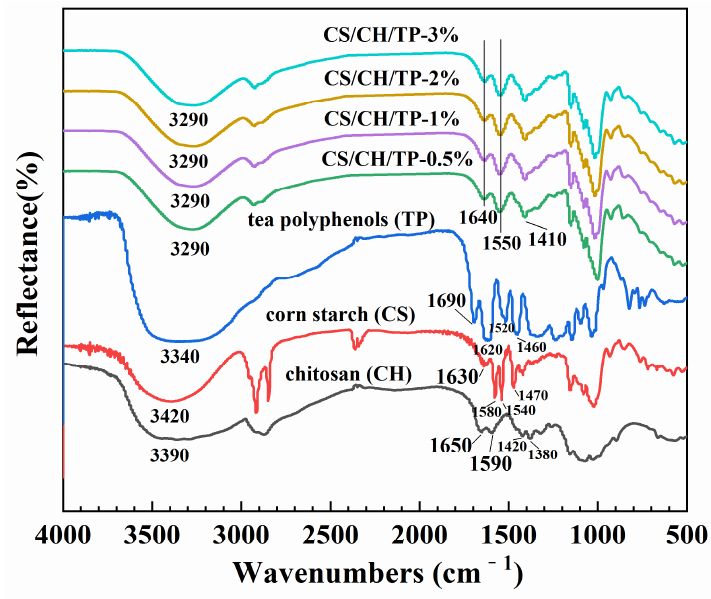
Figure 1. FT-IR spectra for chitosan film, starch film, tea polyphenols and CS/CH/TP films.